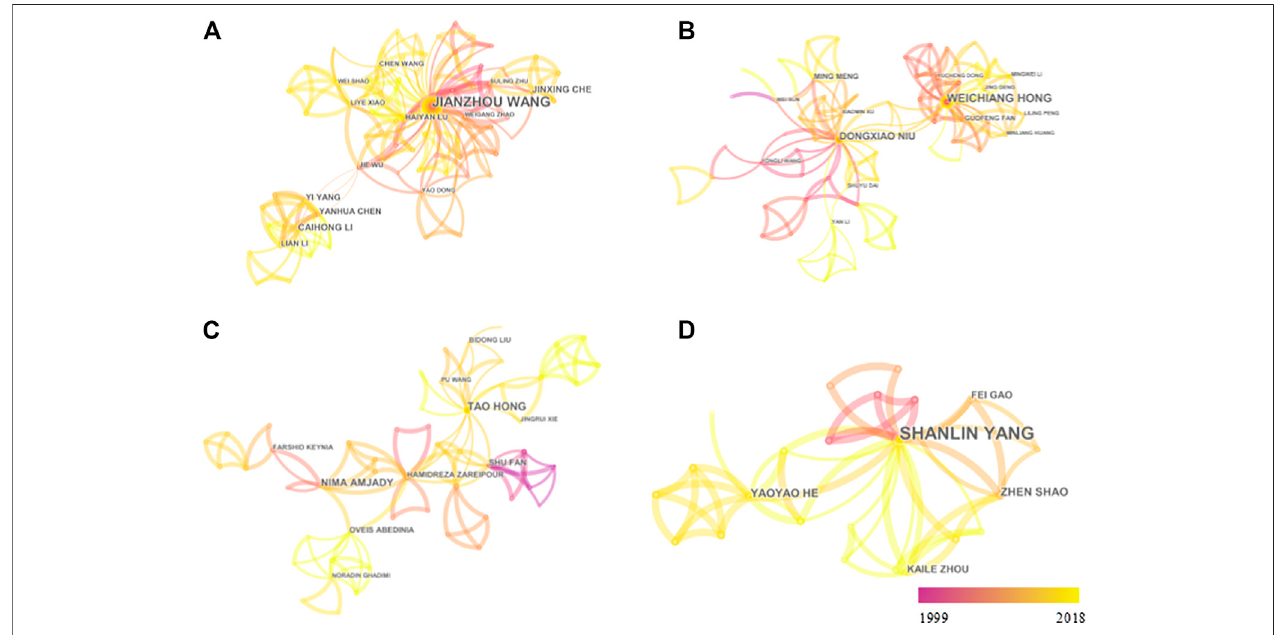
FIGURE 6 | Author cooperation network in electricity demand forecasting ( A , B , C , D represent the four largest cooperative networks).